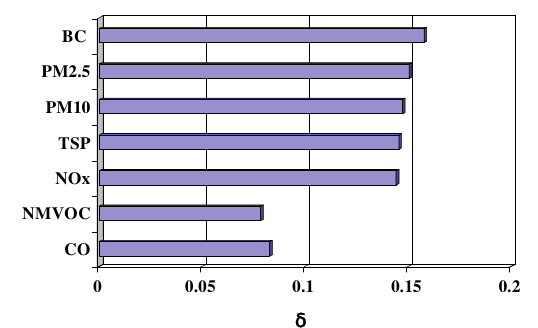
Fig. 15. The relative difference of national annual pollutant emission from motor vehicles in Poland comparing 2015 to 2016